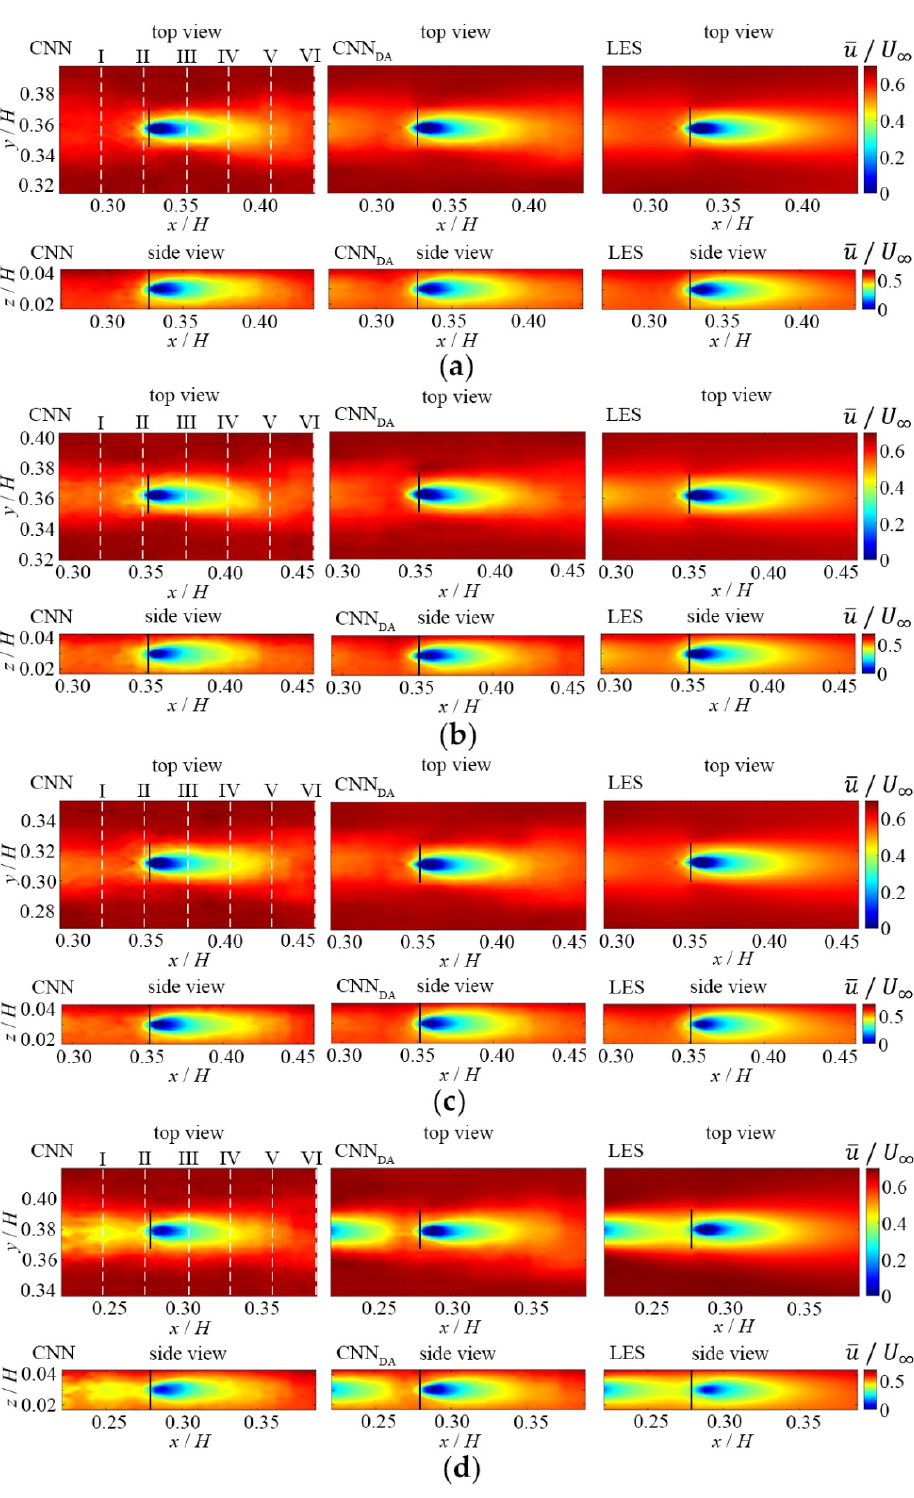
Figure 14. Contours of time-averaged velocity normalized with the free-flow velocity for wind turbines. ( a ) wind turbine 2 in north-east case; ( b ) wind turbine 3 in south case; ( c ) wind turbine 3 in south-west case; ( d ) wind turbine 1 in west case. Top view cross-sections are at hub-height and side-view cross-sections are at the rotor center. Contours are from the CNN, the CNN with data augmentation method (CNN DA ), and the LES results.